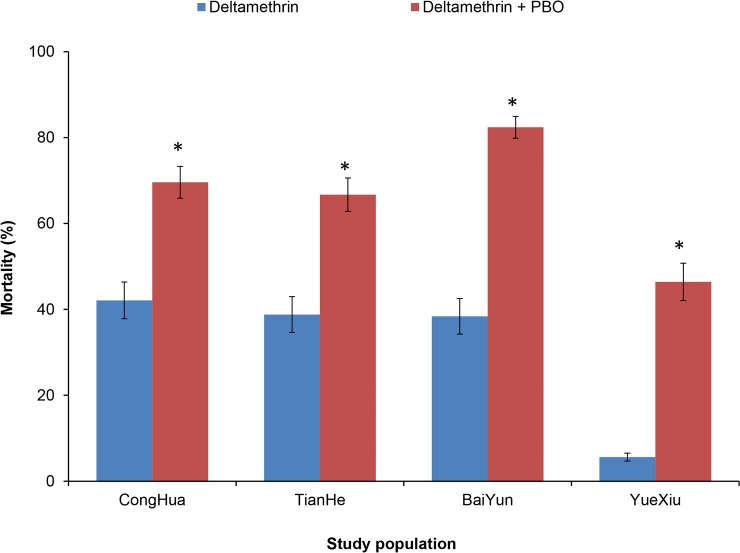
The effect of PBO on the resistance of Aedes albopictus to deltamethrin.Exposing mosquitoes to PBO before exposing them to deltamethrin significantly increased Aedes albopictus mortality compared to directly exposing them to deltamethrin. Error bars indicate 95% CIs. *: p < 0.01.